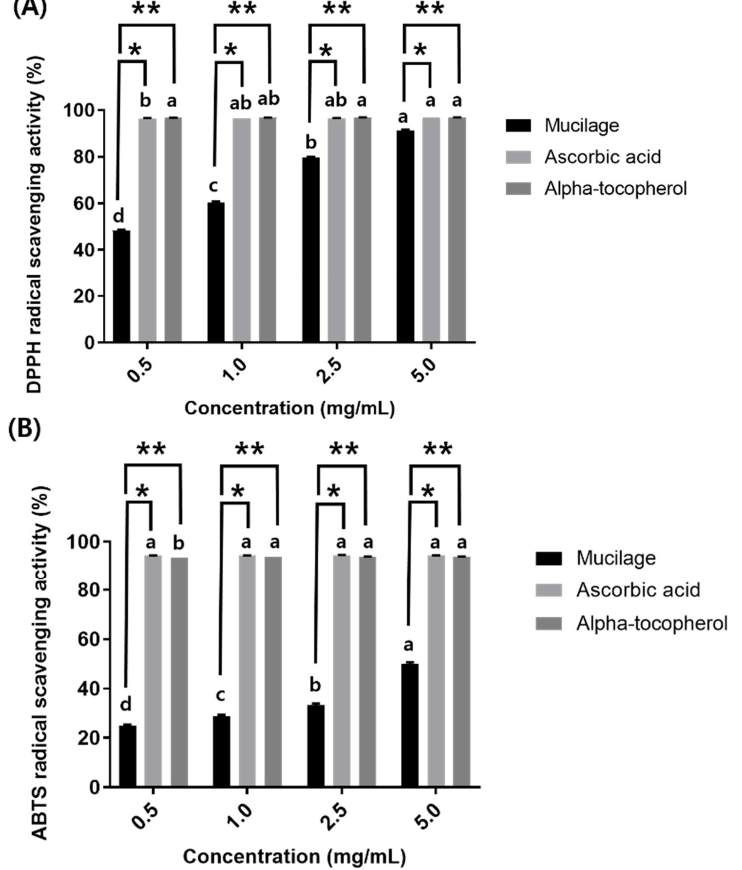
Figure 6. ( A ) DPPH free radical scavenging activity and ( B ) ABTS • + scavenging activity. Values of each bar with different labels (a–d) are significantly different ( p < 0.05) in each sample at different concentrations. Bars labeled with a single asterisk (*) are significantly different ( p < 0.05) between mucilage and ascorbic acid at the same concentration. Bars labeled with a double asterisk (**) are significantly different ( p < 0.05) between mucilage and α -tocopherol at the same concentration.